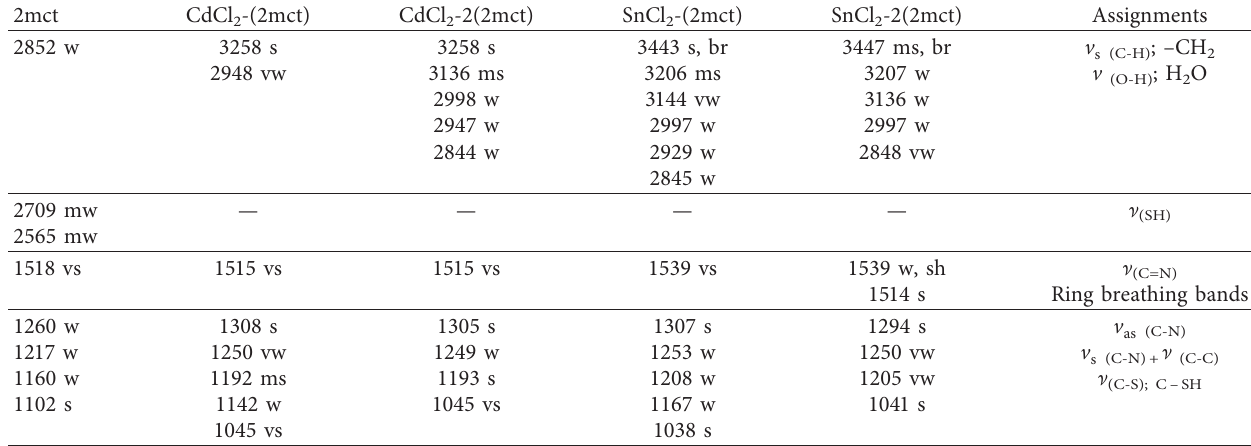
Table 4: Major infrared bands (cm − 1 ) for 2mct and its Cd(II) and Sn(II) adducts.